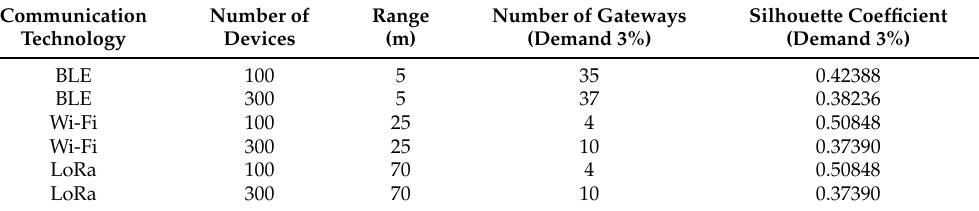
Table 12. The silhouette coefficients after applying the K-means model, considering the number of gateways that resulted from the application of the LP